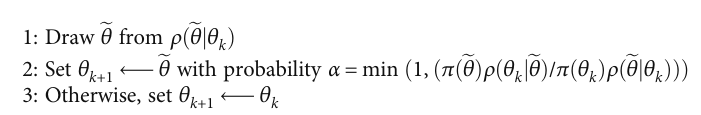
Algorithm 1: Metropolis-Hastings.